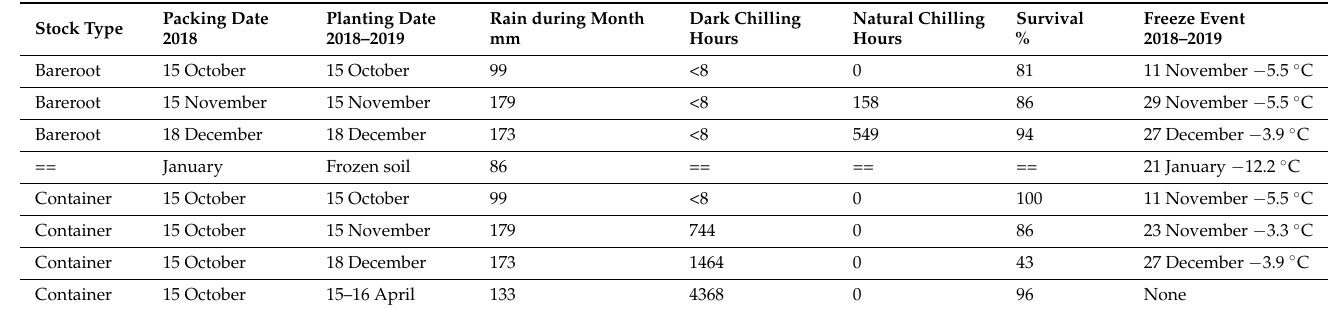
Figure 15. Some researchers prefer to plant container-grown longleaf pine seedlings in moist soil during the fall before December 1, but some wait till the end of December when students are not in school. Sometimes low survival in December is related to planting seedlings with an insufficient amount of freeze tolerance [109]. Each dot ( n = 117) represents one value from a published research trial. For this graph, median survival is 79%, and 24% of the dots are below the 60% line. Technically, there is no wrong month to plant pine seedlings, only a wrong time to plant. For bareroot pines, the planting season in the deep SUS can extend from October to February, but a dry February can be the wrong time to plant pines (Figure 15). An estimate of the amount planted by month might be 1% in October, 5% in November, 15% in December, 40% in January, 25% in February, 14% in March and <1% in April. In Virginia, bareroot seedlings had 81% to 94% survival when planted before 21 December (Table 1). In Louisiana, March and April are the worst months for achieving high survival with bareroot stock [110], while these months are acceptable in regions north of Tennessee and North Carolina [111,112]. Table 1. Survival of bareroot and container-grown loblolly pine seedlings after exposure to dark chilling in a cooler or outdoor chilling (natural chilling) in seedbeds at the Garland Gray Nursery in Virginia. Data from [112]. Rainfall and freeze data from Appomattox, VA. Dark chilling does not increase the freeze tolerance of loblolly pine seedlings [109], and dark freezer storage does not increase the freeze tolerance of ponderosa pine ( Pinus ponderosa Douglas) seedlings [113]. The chilling hours listed below are hours between 0 and 7.2 ◦